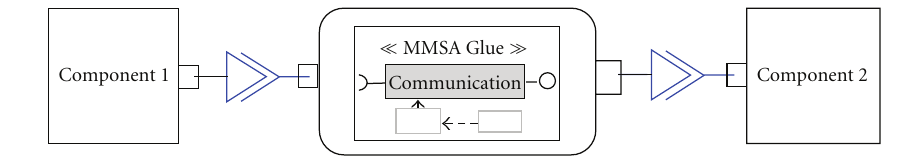
Figure 6: Communication connector.